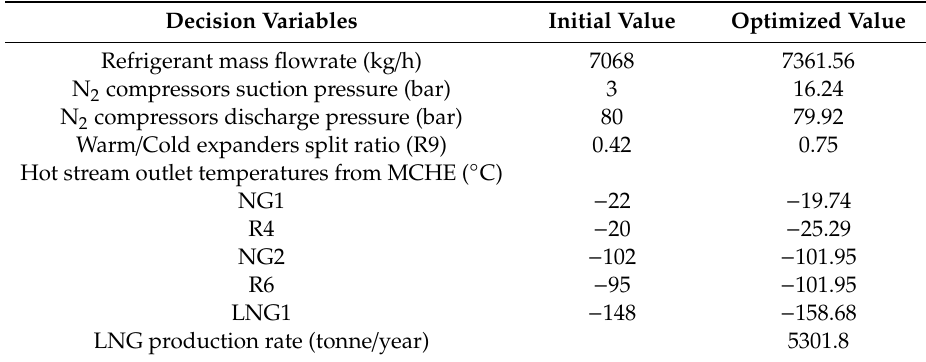
Table A5. Optimization results for dual nitrogen expansion.